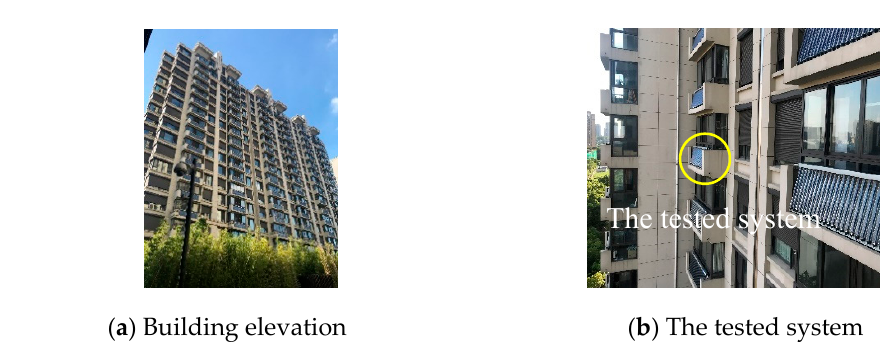
Figure 11. The diagram of the installation nodes.